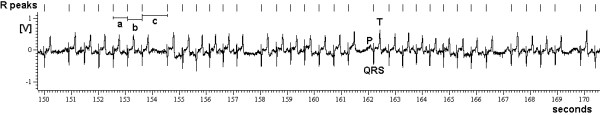
Electrocardiogram of a classical BSE-infected sheep showing cardiac arrhythmia. ECG of a 28 month-old Suffolk wether orally dosed with 5 g of ovine BSE brain homogenate (animal J196), which displayed clinical signs of BSE and presented with PrPsc accumulation in the brain. P and T waves and the QRS complex are clearly identifiable. R-R intervals are marked above the ECG. The R-R interval c (0.94 sec) is almost twice as long as the previous two intervals, a (0.53 sec) and b (0.54 sec), which is close to the characteristics of sinus arrest.